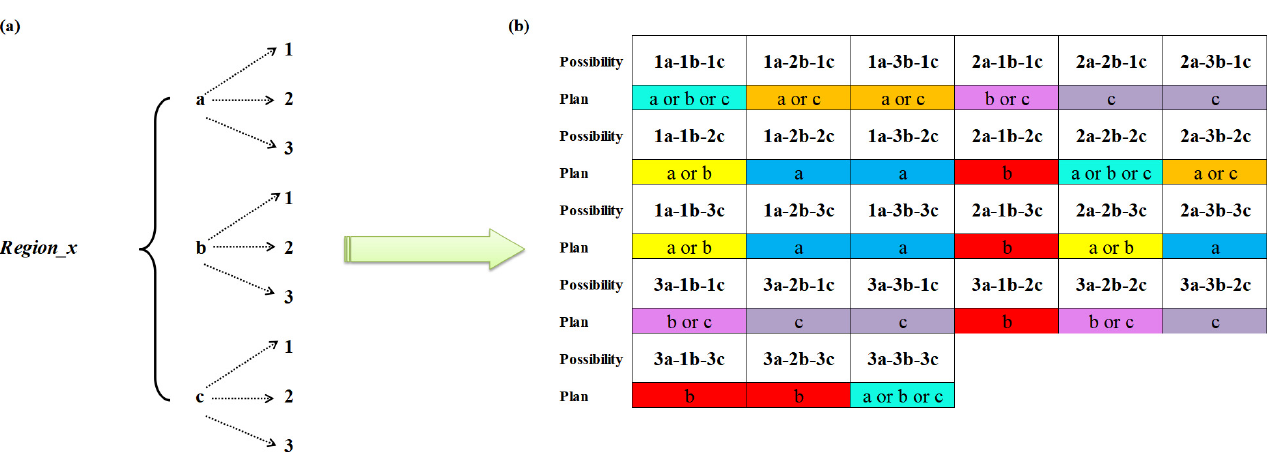
Figure 3. Solutions to the dilemma of the area for different kinds of cotton seed production at the same time, ( a ) Region_ x may be suitable for three cotton varieties for seed production here, and each cotton variety may have three different degrees of suitability for seed production and ( b ) 27 possibilities can be observed. (note, 1: superior, 2: suitable, 3: sub-suitable, a: early-maturing cotton, b: early–medium-maturing cotton, c: long staple cotton, and 1a: superior cotton seed production area for early-maturing cotton).